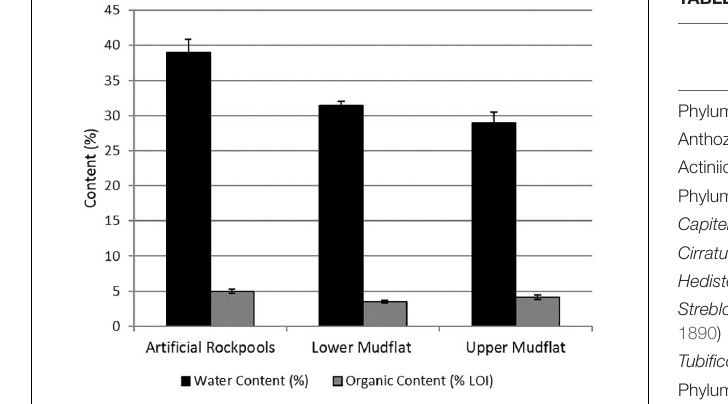
TABLE 2 | Species list for the habitats showing mean density (m 2